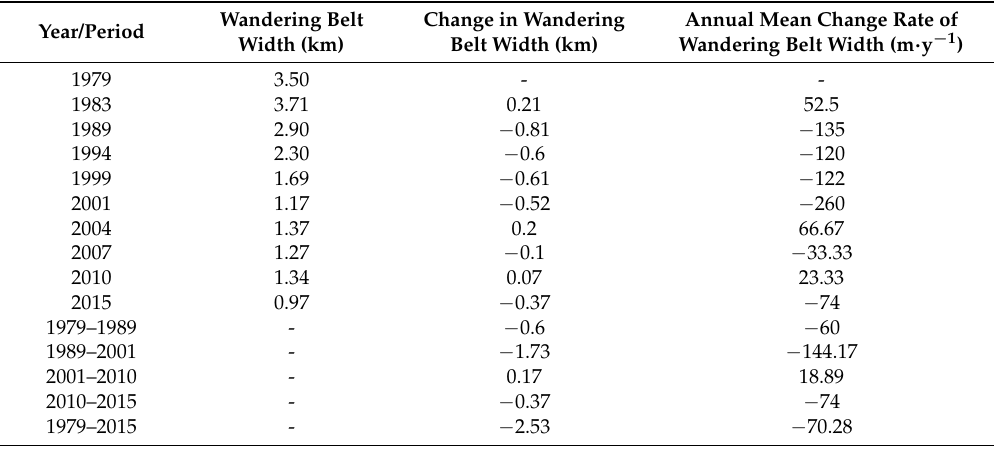
Figure 9. Variation of the wandering belt width in the study reach from 1979 to 2015 (Huayuankou and Xinzhai are two important locations on the wandering reach of the Lower Yellow River). Table 2. Variation of the averaged wandering belt width in the study reach between 1979 and 2015.